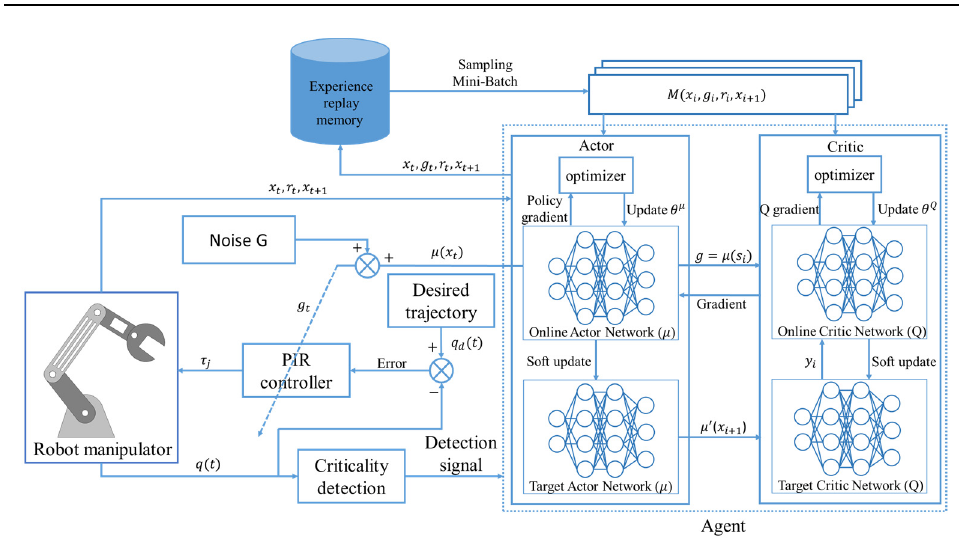
Figure 4. DDPGPIR learning process for the manipulator. Algorithm 1. DDPGPIR Algorithm.